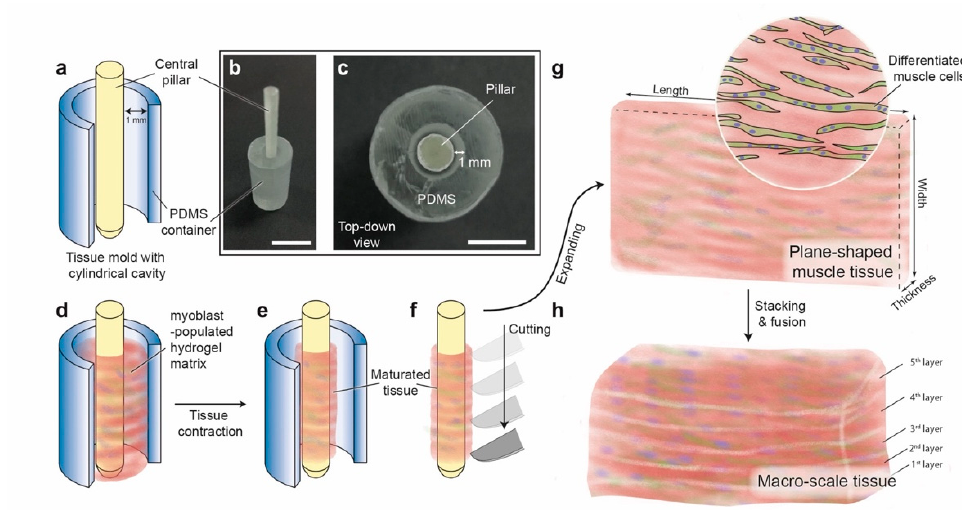
Figure 1. Concept of the cylindrical molding method for the biofabrication of plane-shaped skeletal muscle tissue. ( a ) Design of the tissue mold with a cylindrical cavity consisting of a 3D-printed central pillar and a cylindrical container made of polydimethylsiloxane (PDMS) for better oxygen permeability. ( b ) Photo image of the tissue mold (perspective view). ( c ) Photo image of the tissue mold (top-down view). ( d , e ) The cylindrical molding method starts by casting myoblast-populated hydrogel matrix into the cylindrical cavity of the tissue mold, followed by subsequent maturation of the culture during which the tissue shrinks and the cells differentiate. ( f ) The maturated tissue is collected by withdrawing the central pillar and is subsequently cut vertically. ( g ) Plane-shaped muscle tissue is acquired after expanding the cut tissue. ( h ) A macro-scale tissue block can be constructed by stacking multiple pieces of plane-shaped muscle tissues. Scale bars: ( b ) 1 cm; ( c ) 5 mm.